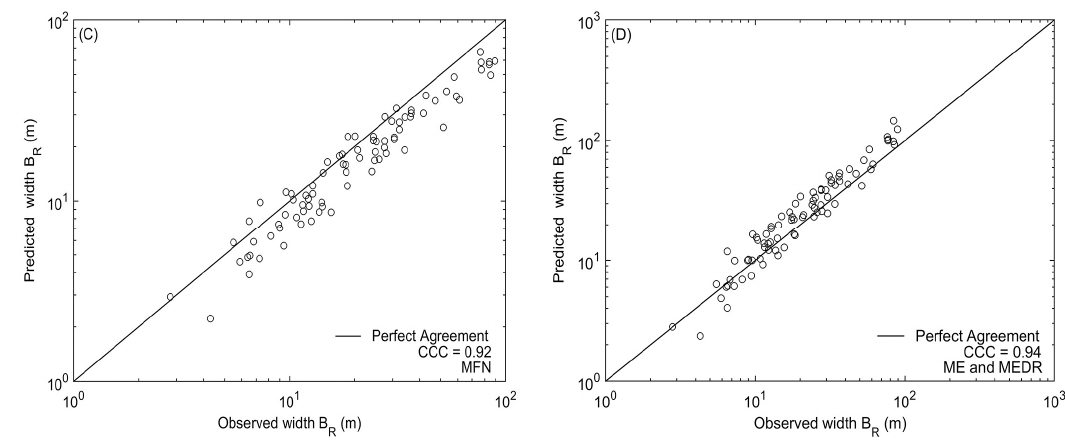
Figure 5. Comparison of predicted and observed width B (cid:2902) for gravel bed channels [2,17,47,48], ( A ) Millar’s Method; ( B ) MFE; ( C ) MFN; ( D ) ME and MEDR.